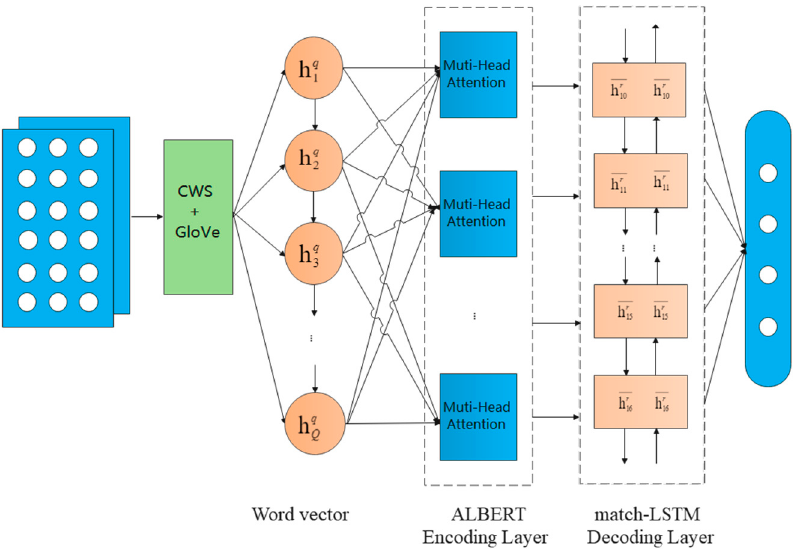
Figure 1. The architecture of our model.